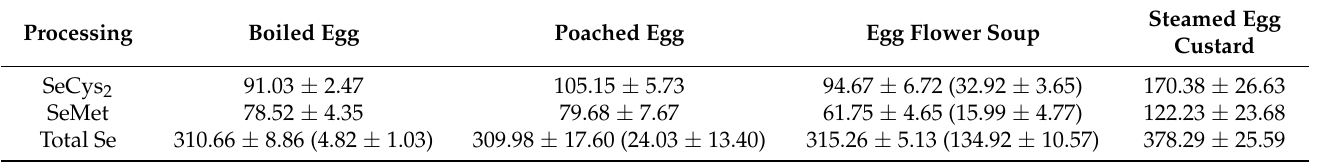
Table 4. Concentration of Se species in cooked eggs a